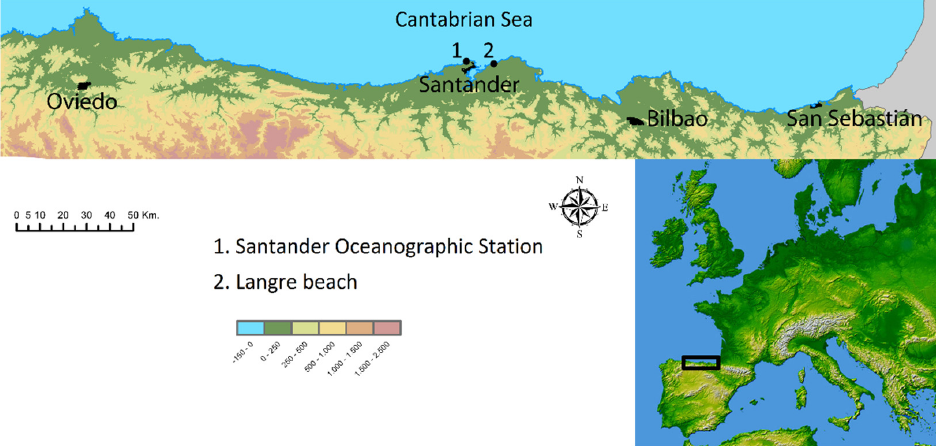
Figure 1. Location of the study area in northern Spain, Santander Oceanographic Station, and Langre beach.